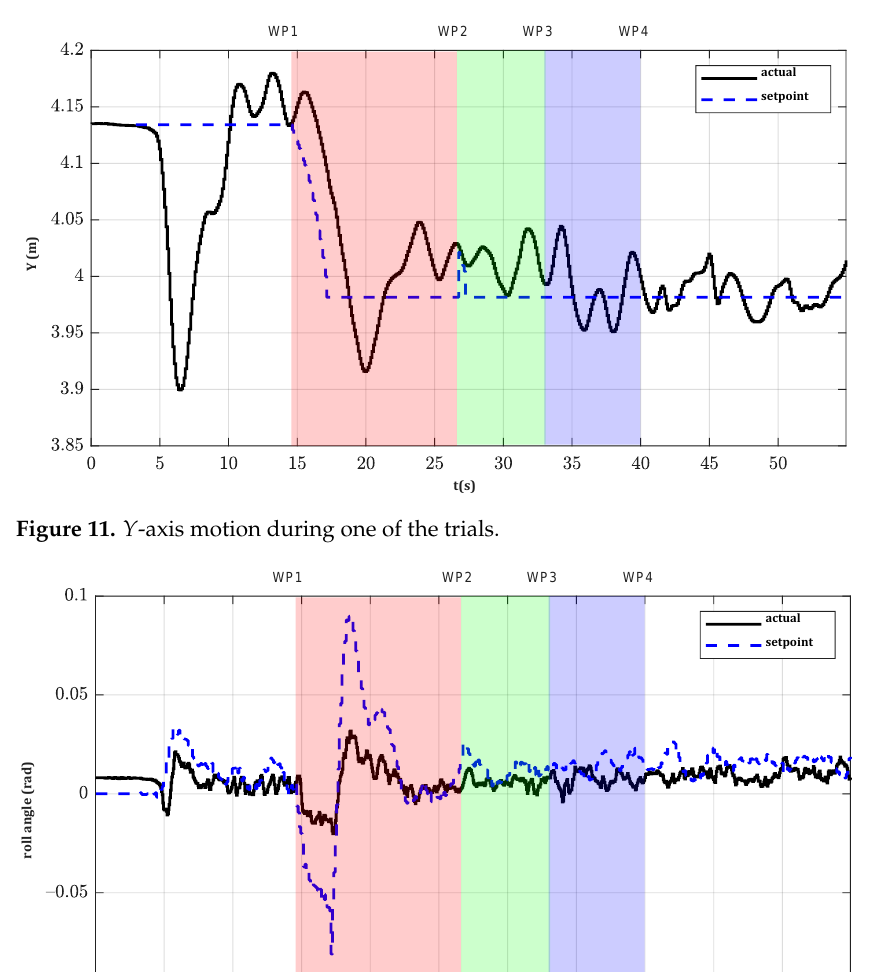
-axis motion during one of the trials. Figure 10.